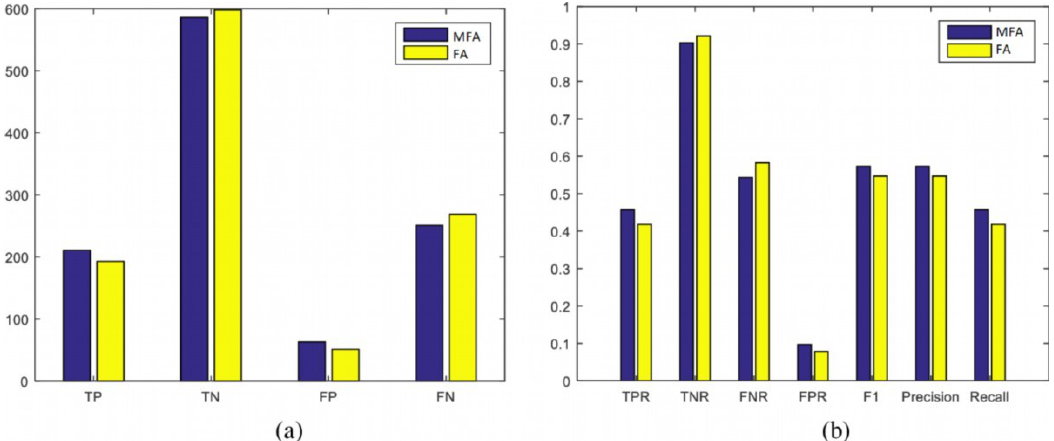
Figure 14. Scenario 3: Statistical evaluation of MFA-OSELM and FA-OSELM using two sets of measures, ( a , b ), for the UJIIndoorLoc dataset.